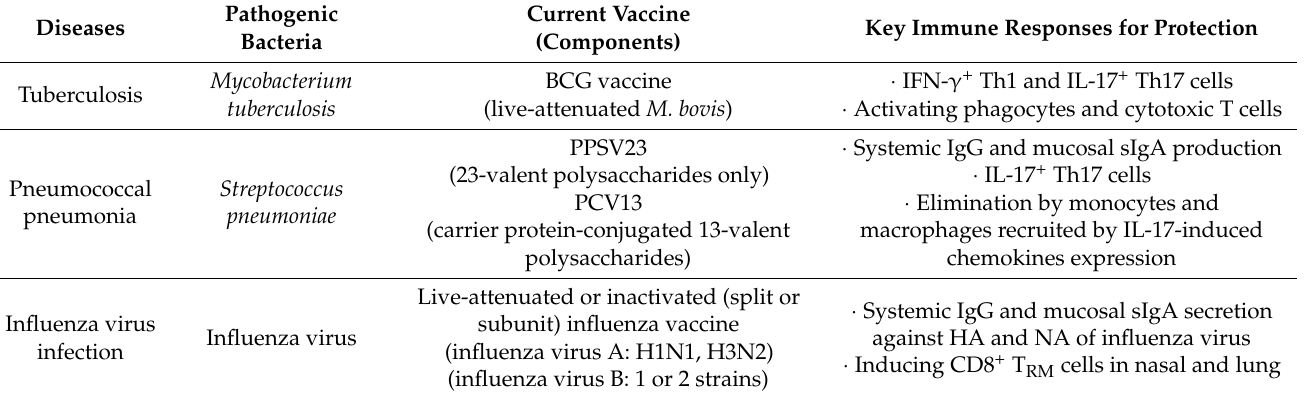
Table 1. Current vaccines against respiratory tract diseases and their key protective mechanisms.